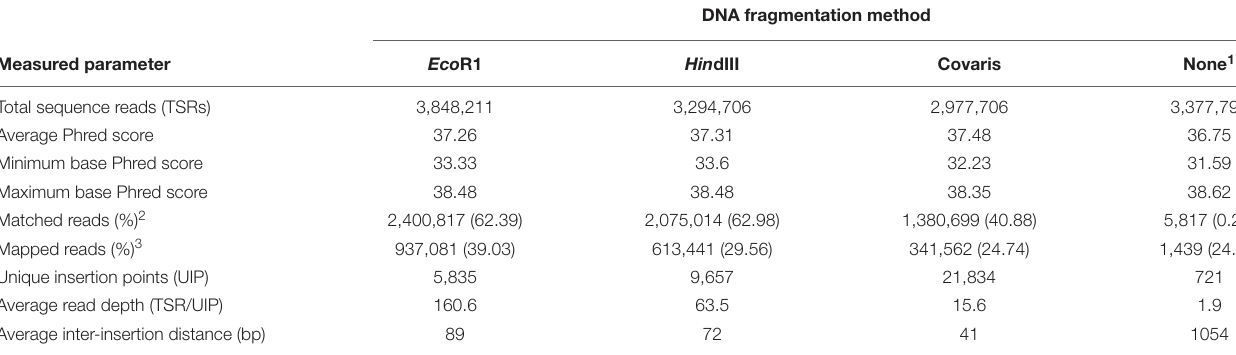
TABLE 1 | Analysis of sequences by inverse PCR obtained from gDNA and preparations enriched for DNA flanking pGh9:IS S1 insertions.